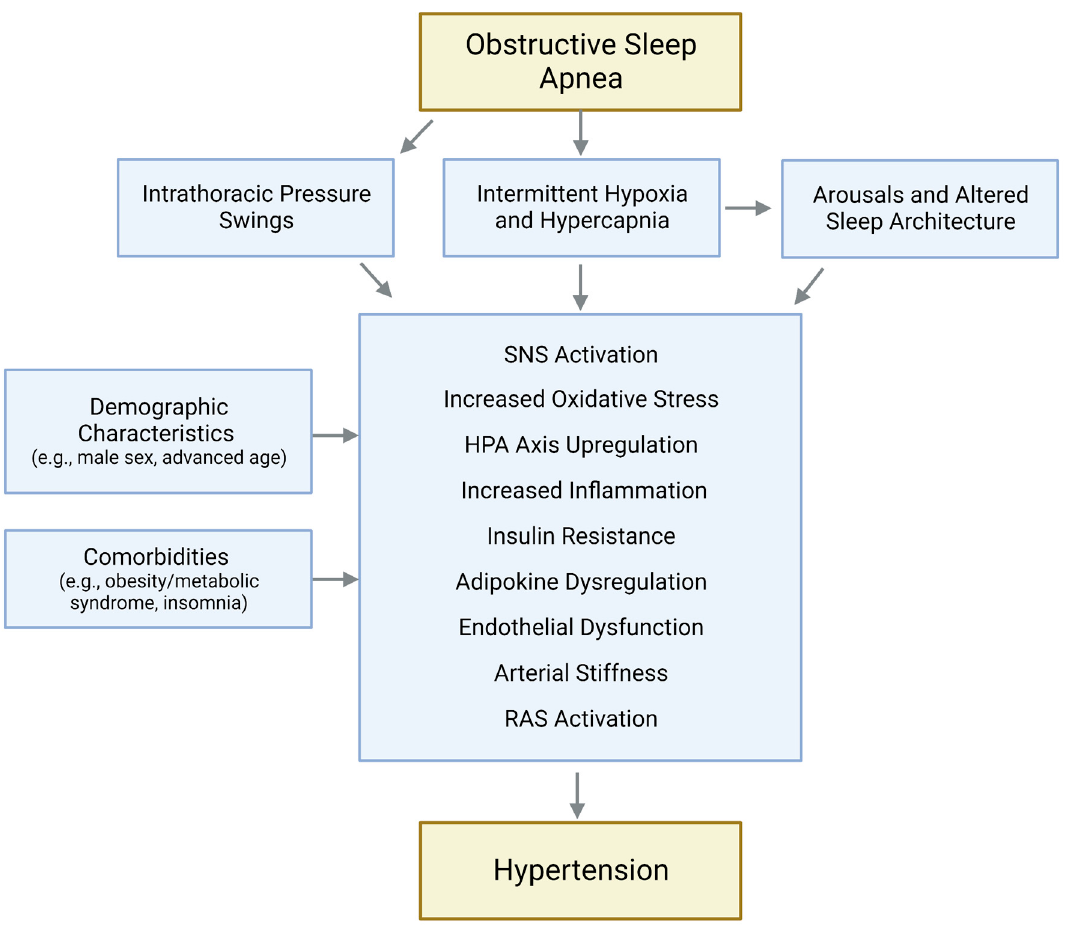
Figure 1. Pathophysiology of hypertension in obstructive sleep apnea. HPA—hypothalamic–pituitary–adrenal; RAS—renin–angiotensin system; SNS—sympathetic nervous system. Created with BioRender.com.